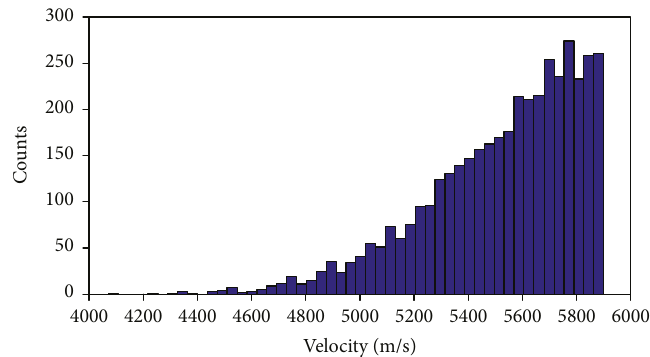
Figure 12: The velocity distribution applied considering a physical perturbed layer (PPL) 100 m in